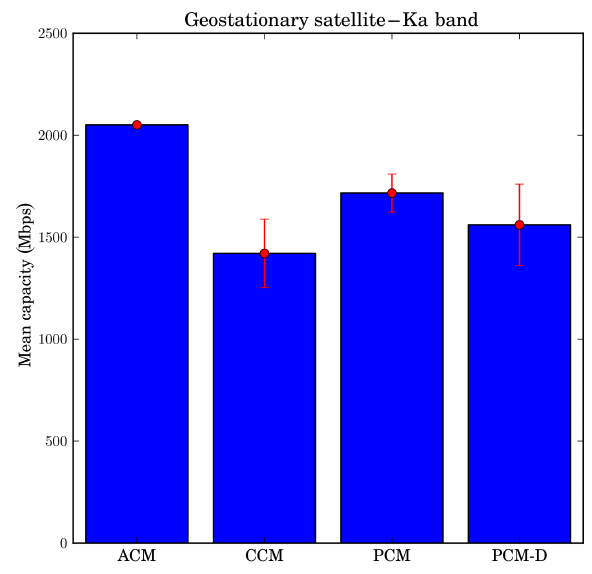
Figure 9. Mean capacities obtained for a target availability of 99.9% considered from a geostationary satellite. Comparison of ACM, CCM, PCM and PCM-D deterministic strategies. The box plots indicate the standard deviation of the